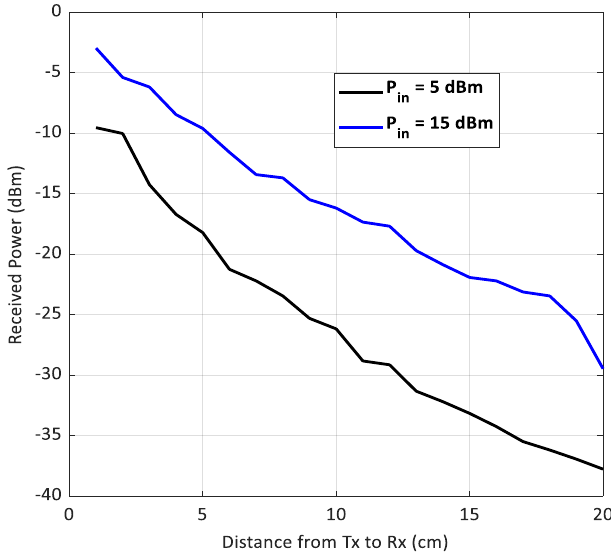
Figure 20. Received power for the input transmitter power of 5 dBm and 15 dBm.